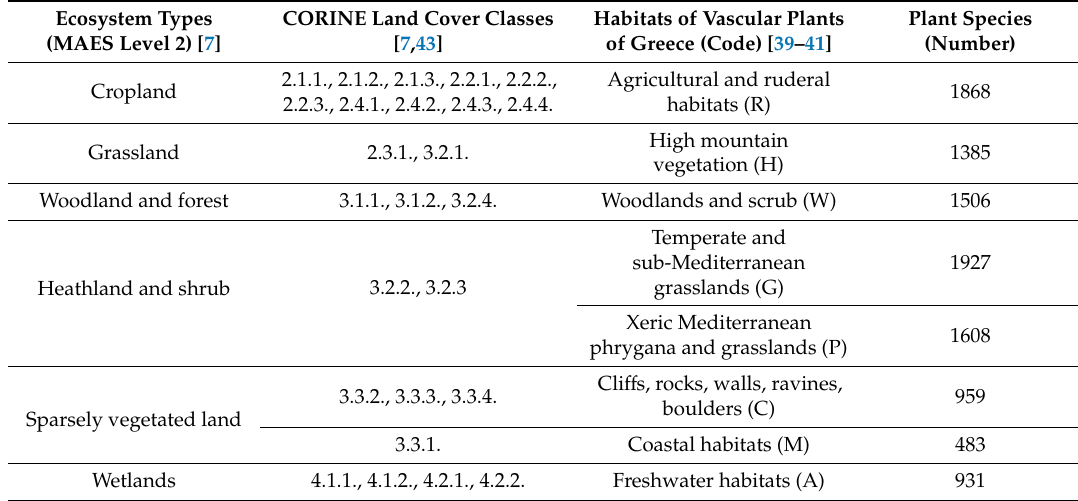
Table 2. Correspondence between ecosystem types (MAES level 2), Corine Land Cover classes ecosystem types, and habitats of the vascular plants of Greece. The total number of species present in each category is also